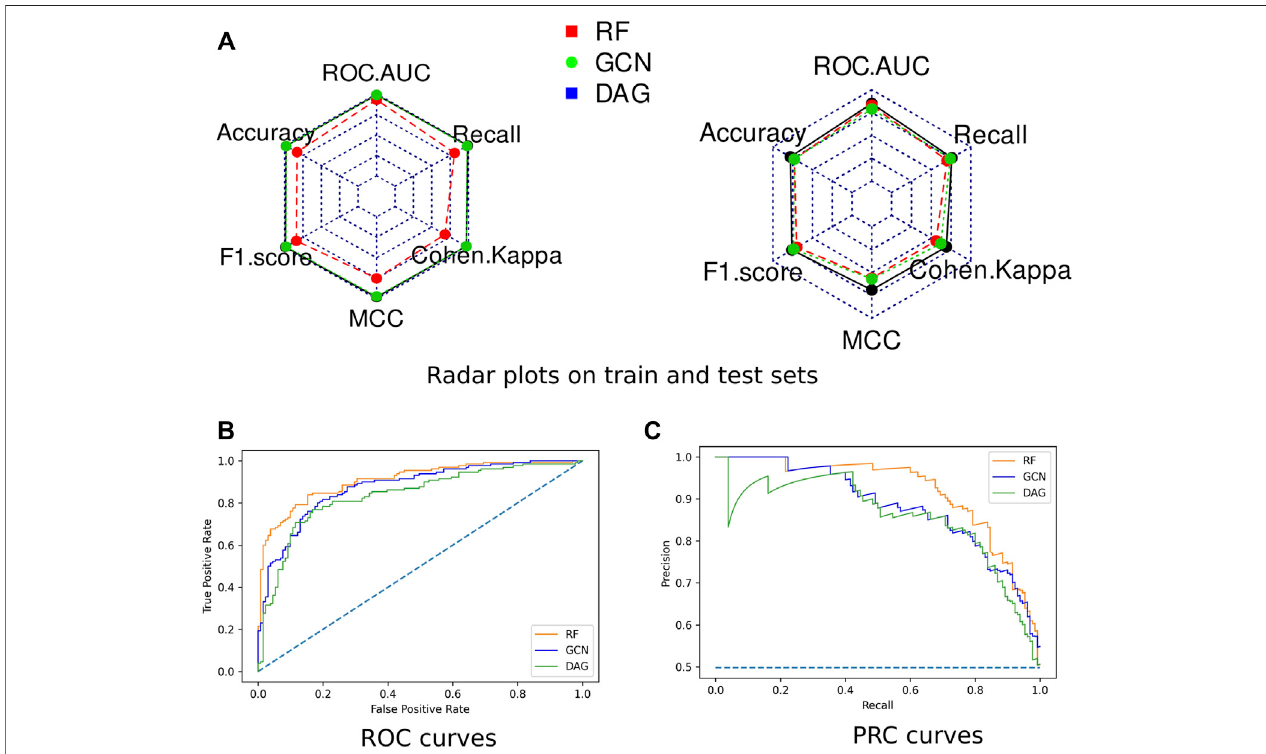
FIGURE 3 | Performances of the optimized models. (A) Radar plots of the models ’ performances assessed on the train set (left) and the test set (right) through ROC-AUC, F1-score, Accuracy, Cohen ’ s Kappa, MCC, and Recall. (B) The ROC curve of all three models. (C) The Precision-Recall (PR) curve of all three models.